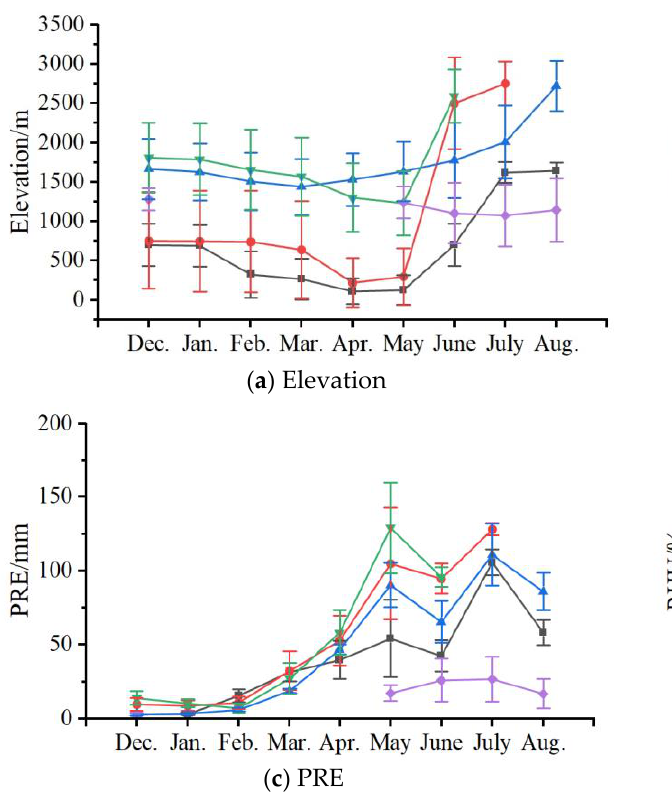
( h ) LAI Figure 7. The mean and standard deviation of environmental variables in high-potential areas of major stripe rust ecological zones; ( a – h ) represent different environmental variables. 4. Discussion This study used several types of variables to build the model. The results show that the epidemic of stripe rust is facilitated by a combination of factors, and various combina- tions of environmental factors can provide suitable living conditions for stripe rust. Meteorological factors are the most important in modeling, with temperature and precipitation being the two most important. Temperature is most important in winter and early spring. Hu et al. built a temperature-based model for evaluating the overwintering potential of stripe rust using the temperature from 16 December to 15 March of the